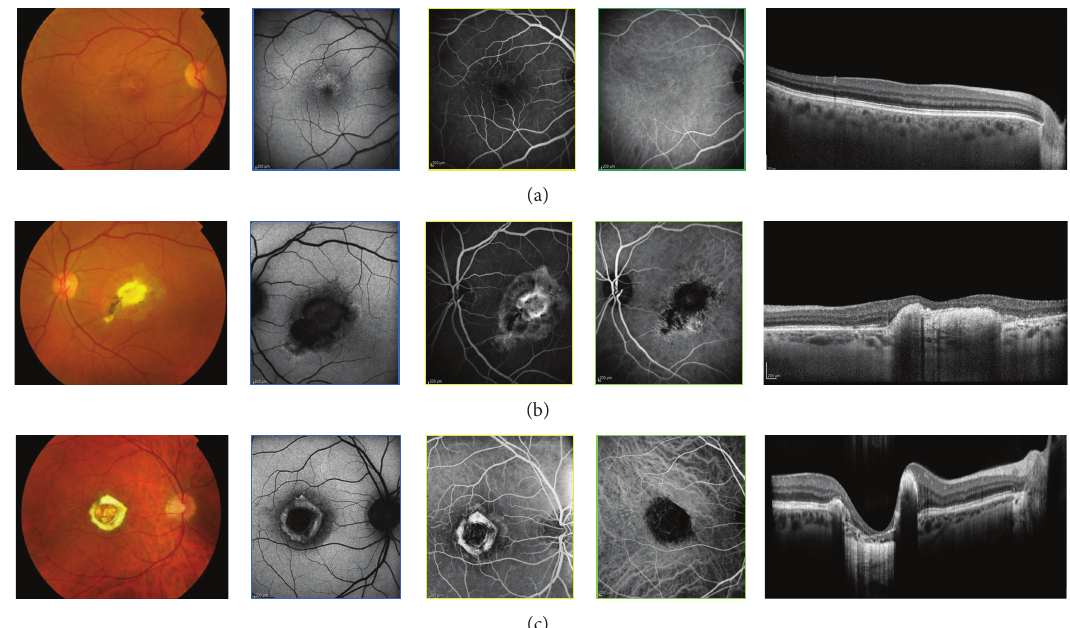
Figure 1: Fundus photographs of affected patients with North Carolina macular dystrophy, showing fine, confluent drusen in the macula (grade I), a subretinal scar due to a prior choroidal neovascularization (Grade II), and a macular caldera (Grade III). In Grade I lesion, autofluorescence shows marked hyperautofluorescence of the bright drusen-like elements. SD-OCT shows a normal anatomy of the inner retina; the photoreceptor-retinal pigment epithelium complex appears normal, and the drusen-like lesions are not detectable. In Grade II lesion, SD-OCT shows increased reflectivity consistent with subretinal fibrosis or gliosis. In the Grade III lesion, fundus autofluorescencedemonstratescentralhypoautofluorescence,surroundedbynormalappearingretinatissueandpreservedfovealtissue.There is a hyperautofluorescent perimeter surrounding the edges of the lesion, possibly indicative of metabolic byproduct deposition. SD-OCT demonstrates a normal hyperreflective IS/OS photoreceptor junction with abrupt attenuation of outer retinal structures and RPE absence within the